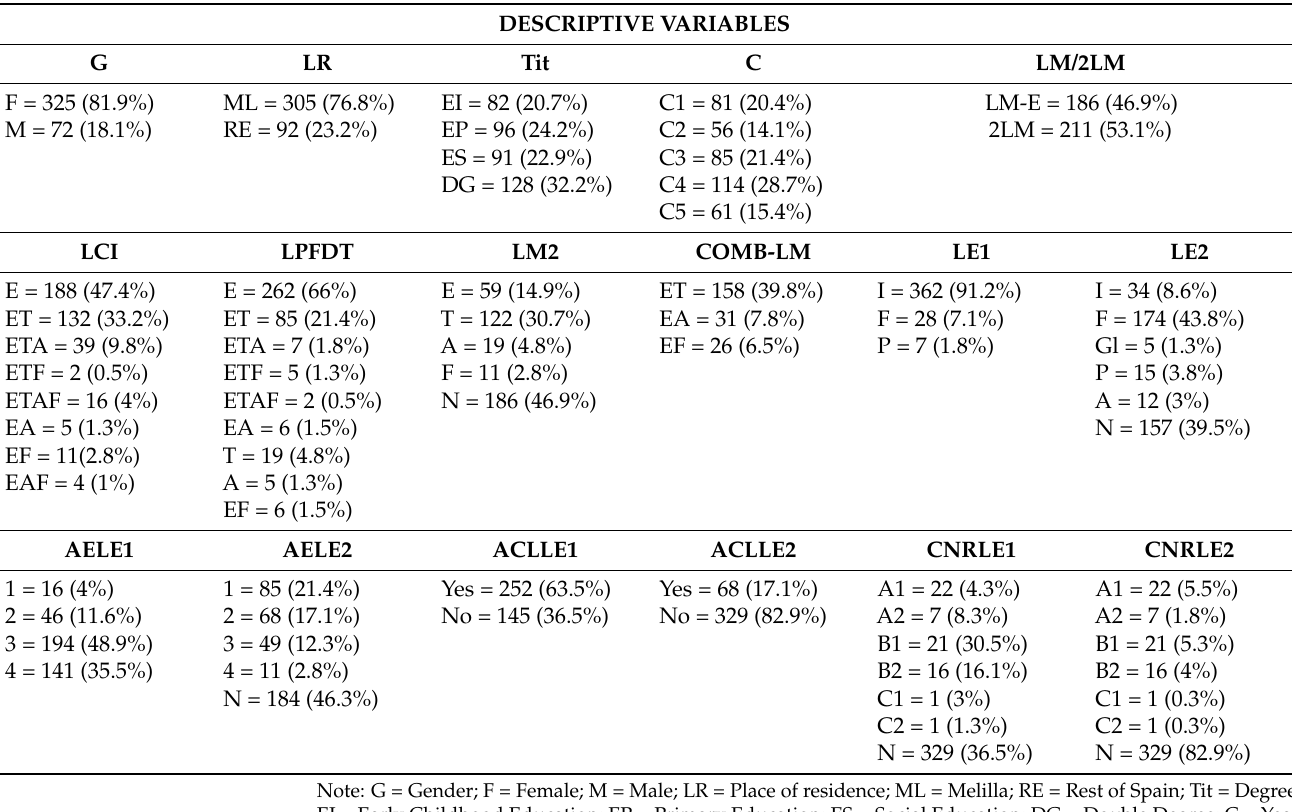
Table 2. Frequency distribution and percentages of the participants according to the descriptive